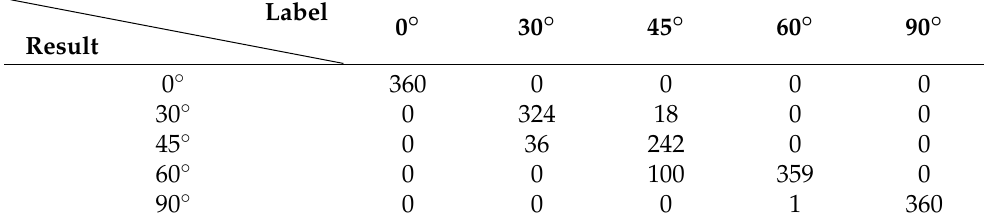
Table 3. A confusion matrix of view classification results.